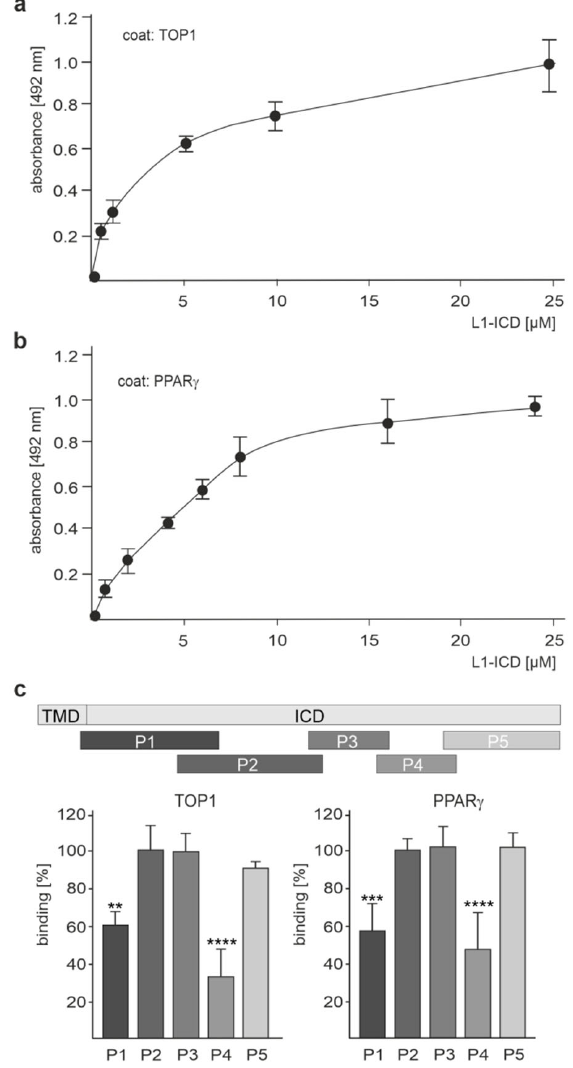
Figure 3. L1-ICD binds to TOP1 and PPAR γ . Recombinant TOP1 ( a ) and PPAR γ ( b ) were substrate- coated and incubated with increasing concentrations of L1-ICD. Binding of L1-ICD was determined by ELISA using mouse L1 antibody C-2 and horseradish peroxidase-conjugated secondary anti- body. Mean values ± SD from three independent experiments carried out in triplicate are shown. ( c ) Recombinant TOP1 and PPAR γ were substrate-coated and incubated with L1-ICD in the absence or presence of a five-fold excess of L1 peptides P1, P2, P3, P4 or P5, which cover the entire L1-ICD sequence. The ICD and transmembrane domain (TMD) of L1 and the positions of the pep- tides in L1-ICD are visualized. Binding was determined by ELISA using mouse L1 antibody C-2 and horseradish peroxidase-conjugated secondary antibody. Mean values + SD from five inde- pendent experiments carried out in triplicate are shown for the binding relative to control (values in the absence of peptides set to 100%) (** p < 0.01, *** p < 0.005, **** p < 0.001; one-way ANOVA with Bonferroni’s multiple comparison test). 2.2. TOP1, PPAR γ and NDUFV2 co-Localizes with L-70 in Cerebellar and Cortical Neurons We were able to show that L1-70 was not generated in gene-edited mice expressing either L1 with a mutated dibasic sequence in the third FNIII domain at position 858–863 (L1/858–863 mutant; RKHSKR exchanged by SKHSSS) or L1 with a mutation of arginine 687 (L1/687 mutant; R exchanged by A) [25]. Thus, we used these mutants to substantiate the view that L1-70 interacts with TOP1, PPAR γ and NDUFV2. Since treatment of neu- rons with L1 antibody 557 promotes the generation of L1-70 [28], cortical neurons from wild-type and L1 mutant mice were treated with or without this antibody and subjected